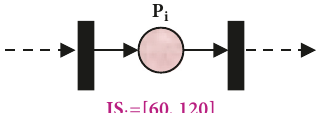
Figure 2: Station